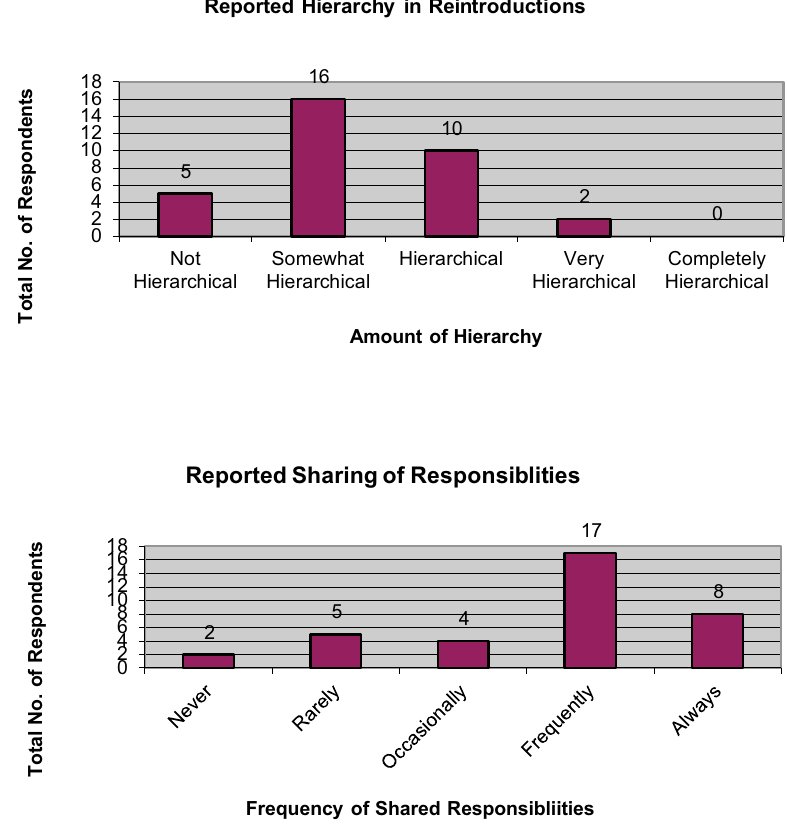
Figure 7. Self-assessed hierarchy in reintroduction programs.